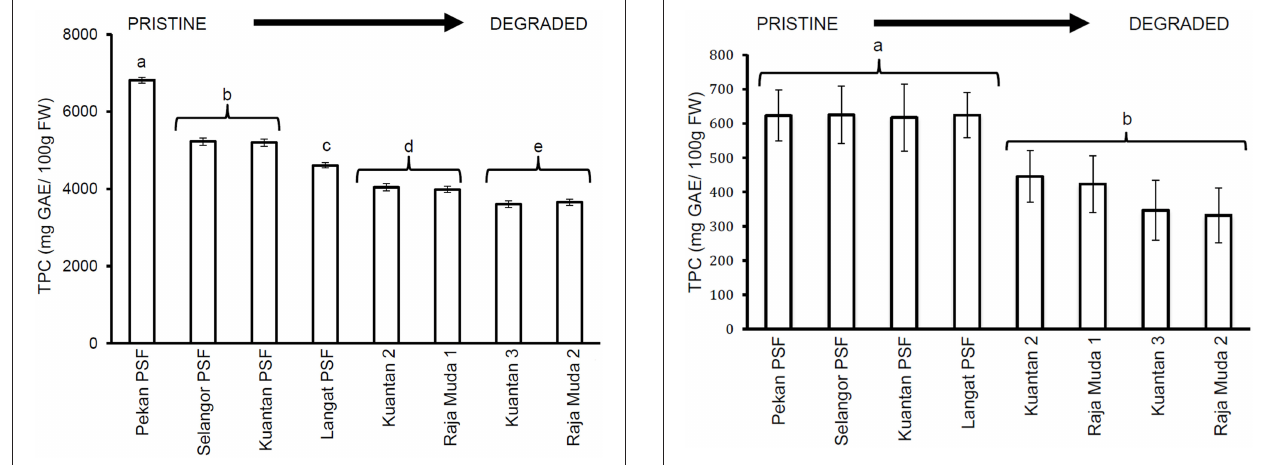
FIGURE 4 | Mean ( ± 1 SD) total phenolic compounds in surface peat at each peatland ( n = 27 except Pekan PSF, n = 9). Values followed by the same letter (a or b) are not significantly different at P < 0.05 as measured by the Tukey HSD test.